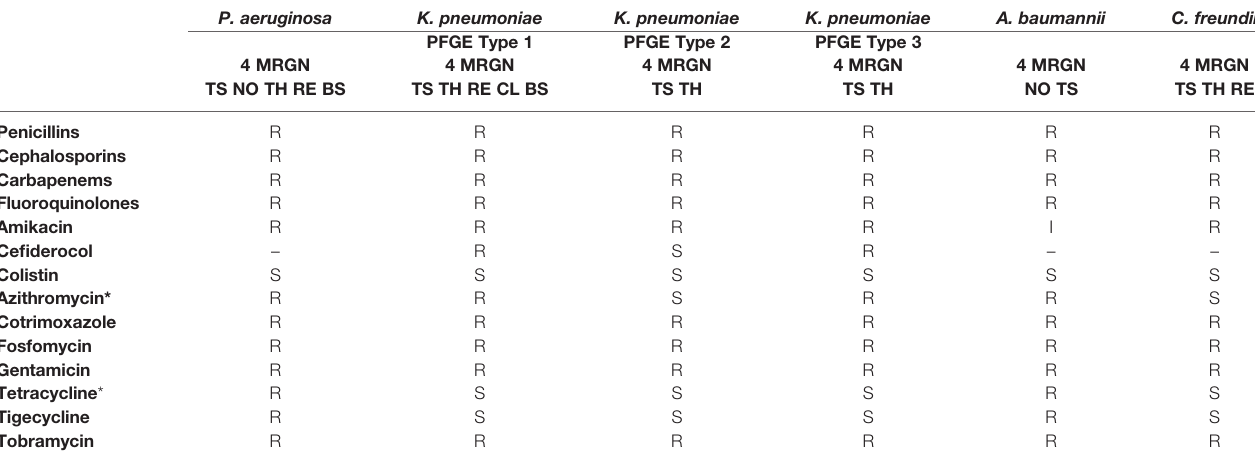
TABLE 2 | Bacterial infections of the patient with antibiogram.